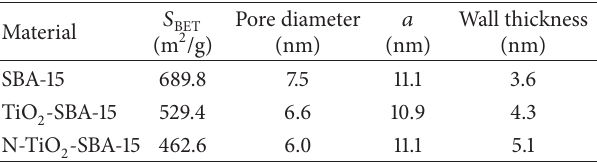
Table 1: Structural, textural properties of the pure SBA-15, TiO SBA-15, and N-TiO